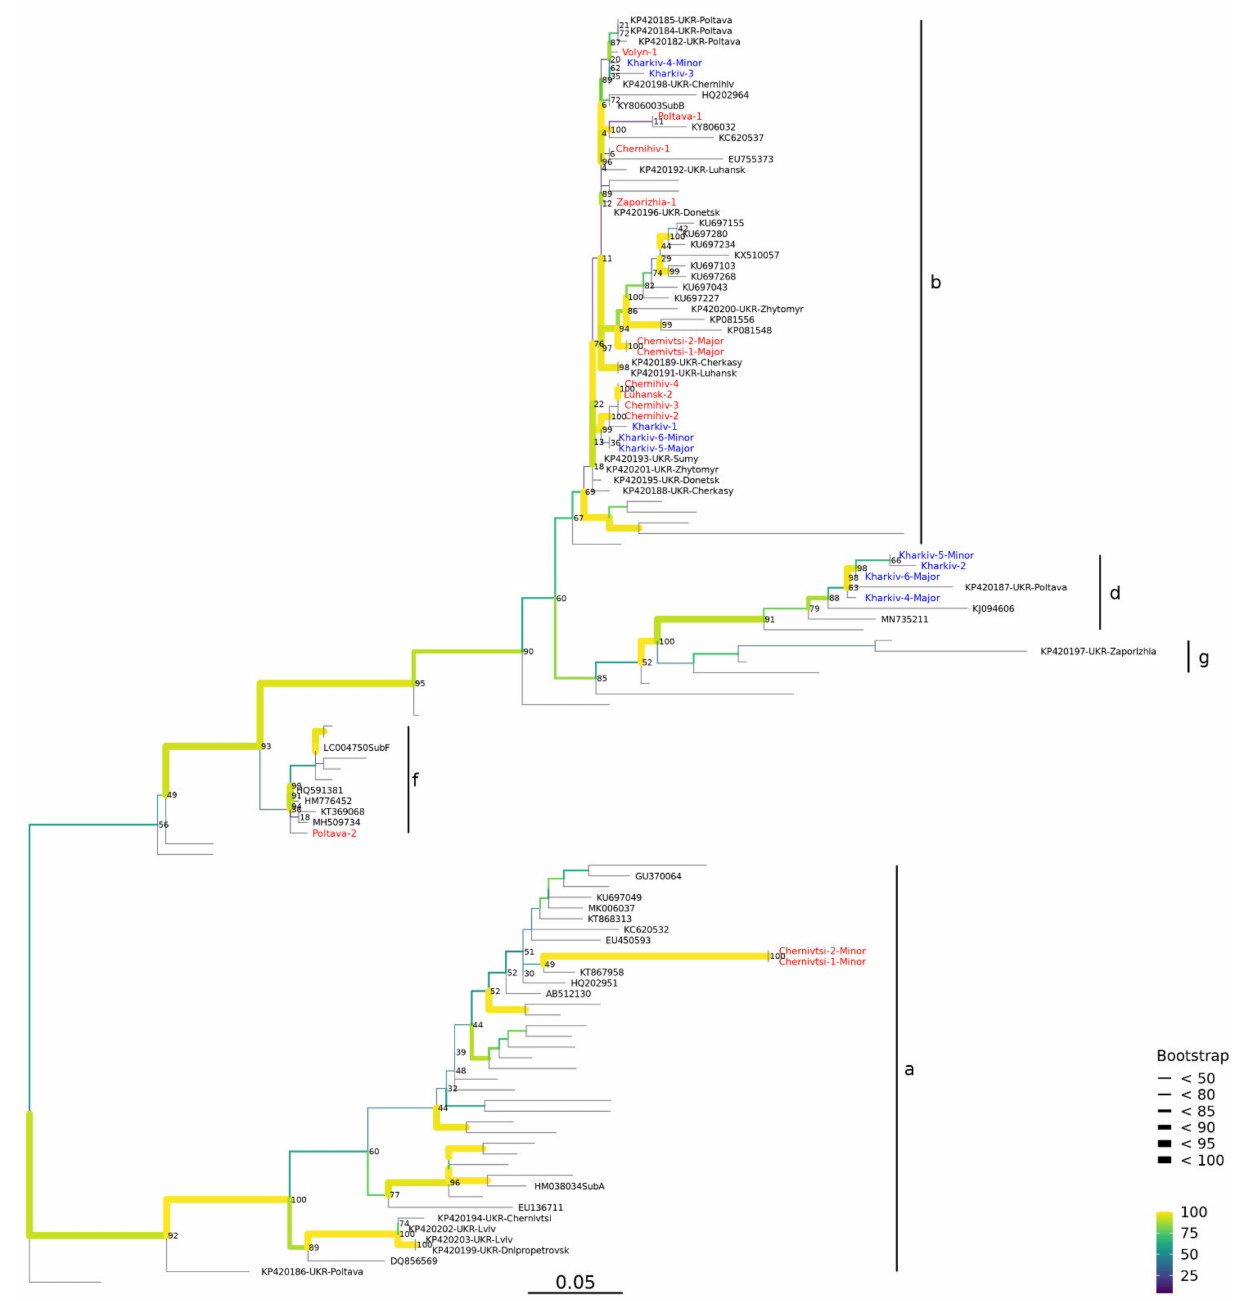
Figure 2. Phylogeny of porcine circovirus 2 in Ukraine. A maximum-likelihood tree was inferred for PCV2 ORF2 (Cap) genes from our study (red, wild boar; blue, domestic pig), and sequences downloaded from GenBank (Accessions). PCV2 co-infections sequenced in this study are labeled (–major and –minor), with PCV2 subtype clades identified (a, b, d, g, and f). The genotype-defining reference sequences are the major PCV2 lineage assignment with indicated GenBank Accessions (designated sub or described in the